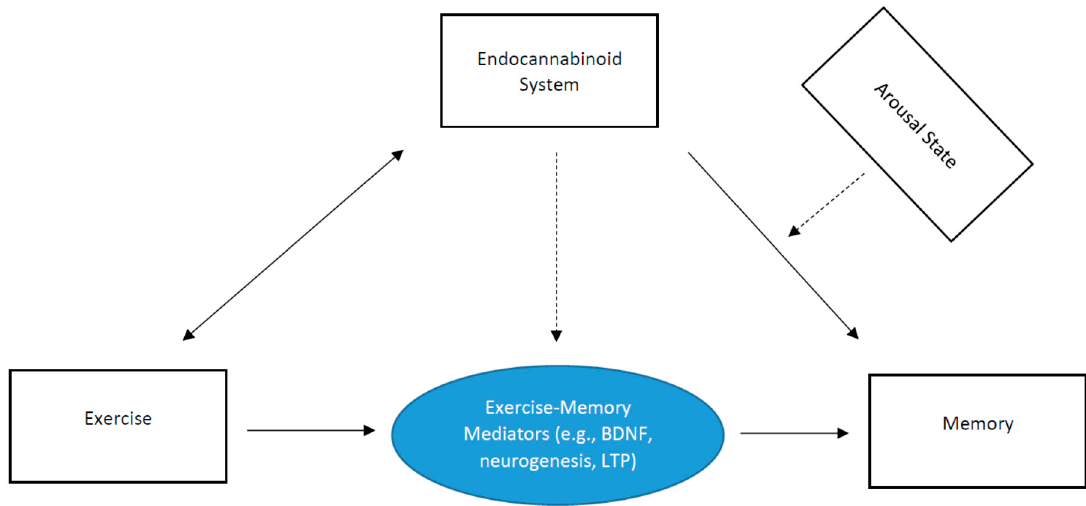
Figure 1. Schematic depicting the role of the endocannabinoid system on the exercise-memory interaction. The dashed lines indicate a moderation effect.